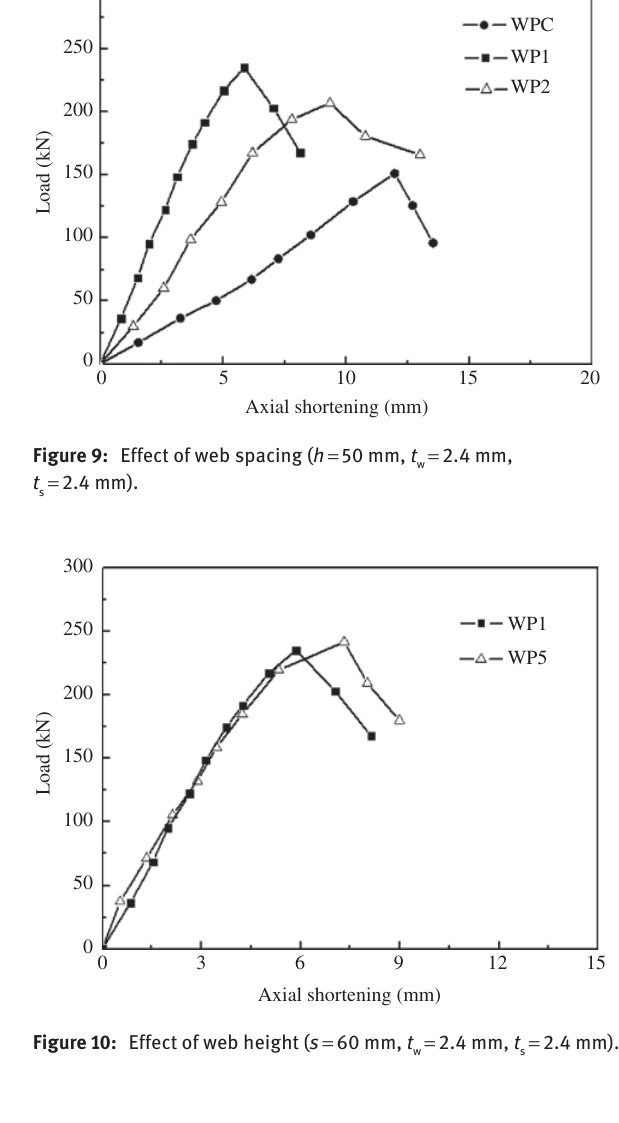
Figure 10: Effect of web height ( s = 60 mm, t